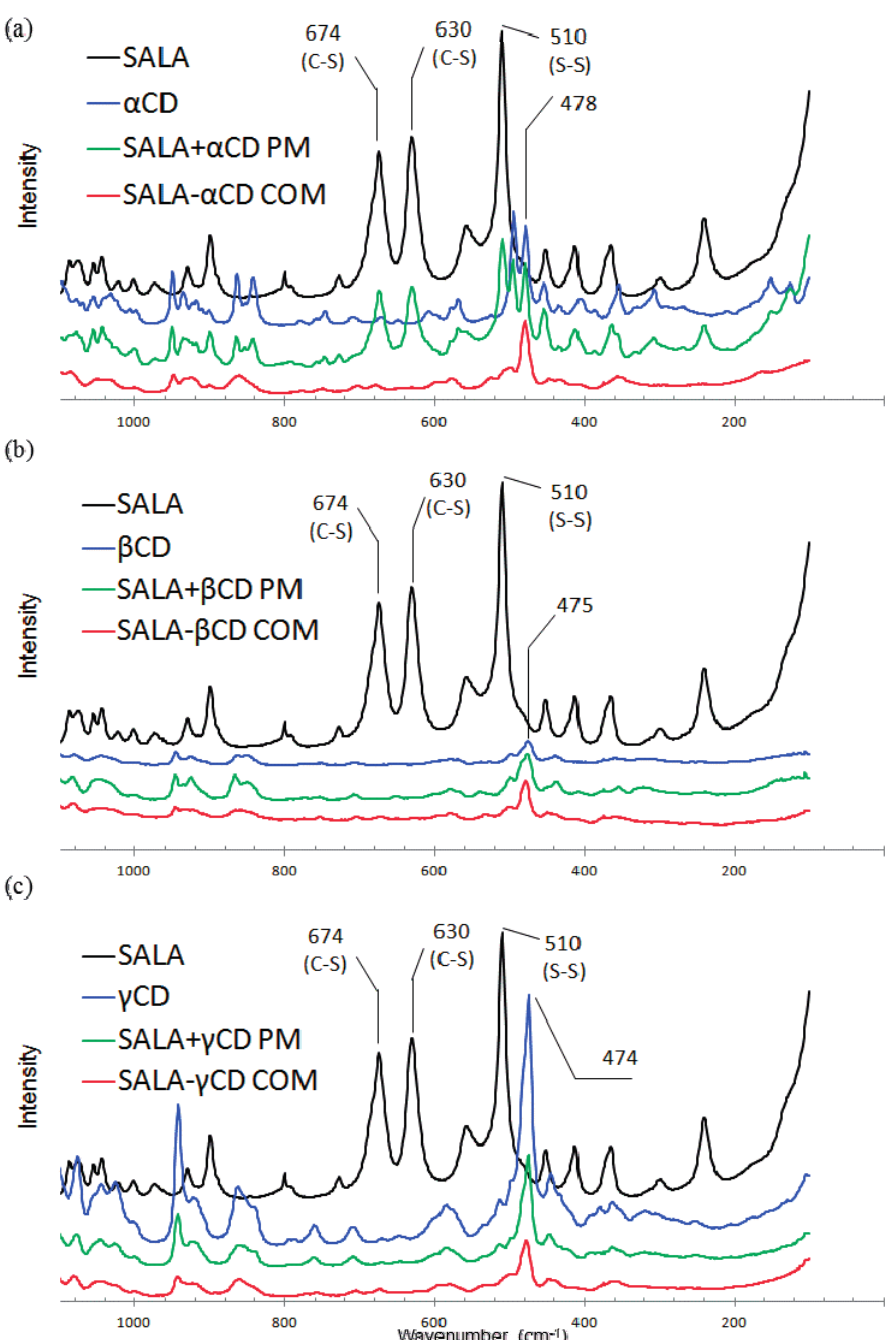
Figure 8. Raman spectra of SALA-CD complexes. (( a ) α -CD; ( b ) β -CD and ( c ) γ -CD) (COM: Complex, PM: Physical